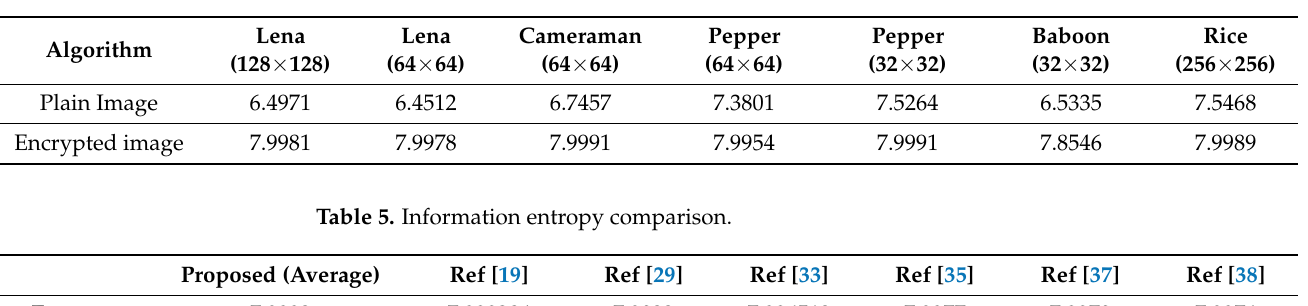
Table 4. Information entropy values of Ciphertext images.